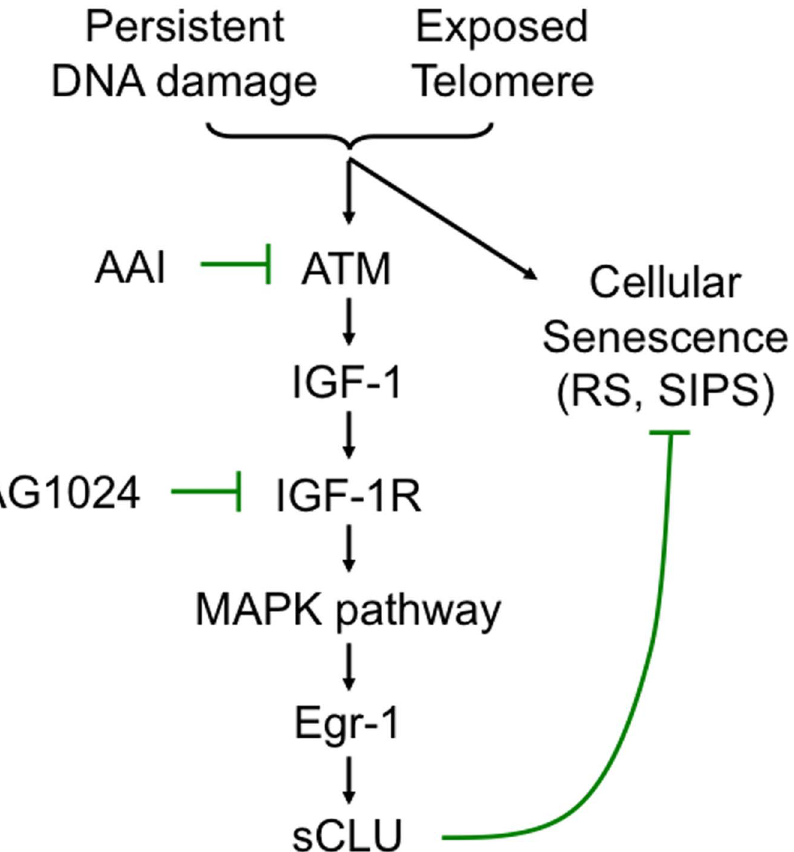
Figure 6. A model of the signaling pathway that mediates sCLU induction during senescence showing the role of sCLU in senescence compared to IGF-1/IGF-1R signaling required to prevent apoptosis. AAI and AG1024 are small molecule chemical inhibitors that inhibit ATM and ATR, and IGF-1 tyrosine kinase receptor (IGF-1R), respectively.